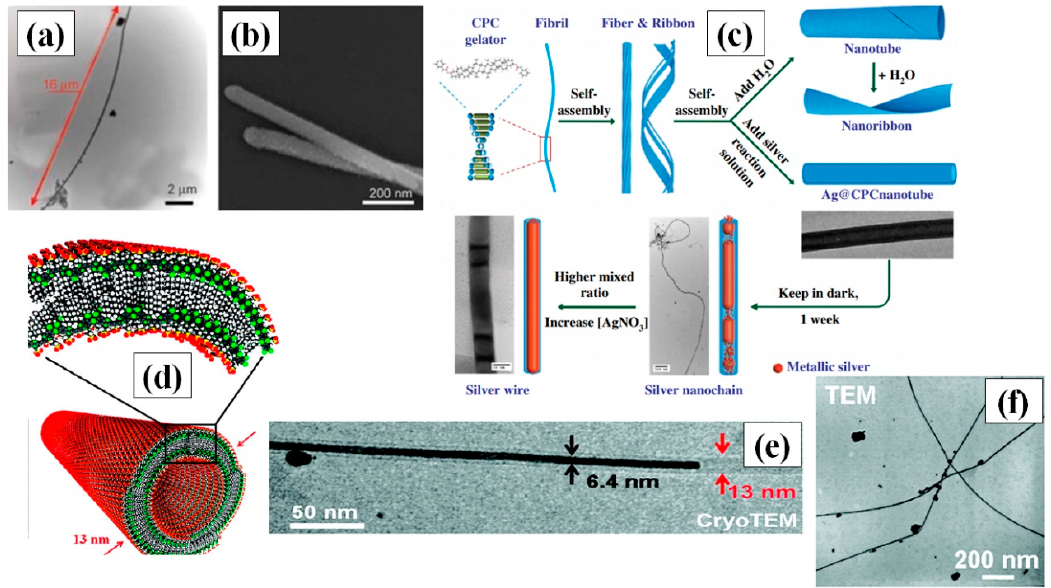
Figure 3. ( a ) TEM images confirming the maximum width and length of the AgNWs ( b ) SEM image of synthesized AgNW (adapted from [60] with permission from Express Polymer Letters, 2018). ( c ) Schematic diagram of the formation of CPC nanotubes and their aid in AgNW growing via a classical mirror reaction (adapted from [59] with permission from John wiley and sons, 2004). ( d ) Illustrating the self-assembled double walled nanotubular J-aggregates dyes with an outer diameter of 13 nm ( e ) Transmission electron microscopy (TEM) image of a AgNW with a width of 6.4 nm partially filling a supramolecular dye nanotube, and a silver nanoparticle on the nanotube’s outside 15 min after adding AgNO3 to the solution, ( f ) TEM image of synthesized AgNWs using J-aggregate, (72 h after adding AgNO 3 ) (adapted from [62] with permission from ACS publications,